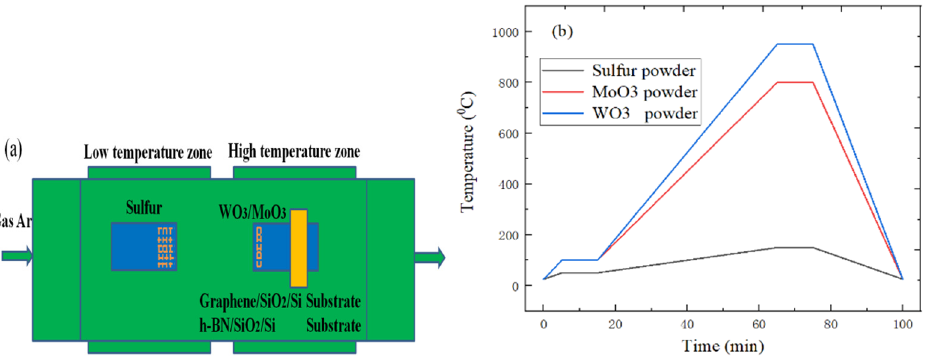
Figure 14. ( a ) Experimental schematic diagram of WS 2 and MoS 2 growth; ( b ) The relationship between temperature and time in different heating